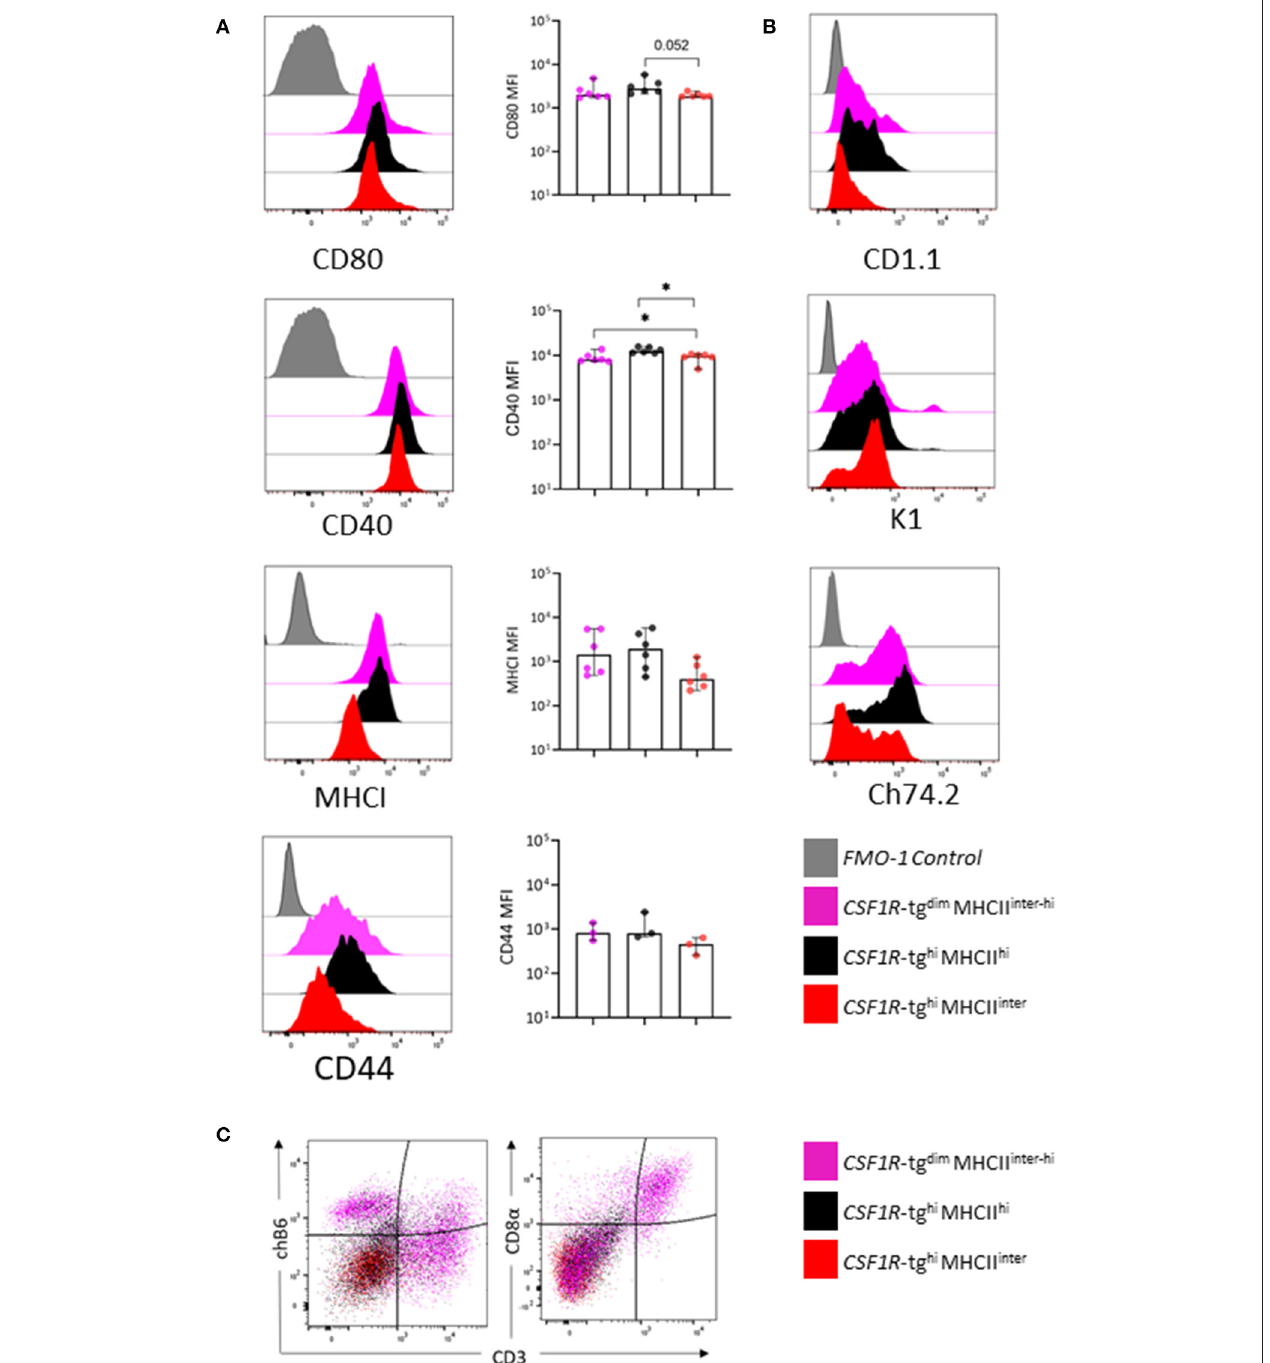
FIGURE 4 | The CSF1R -tg hi MHCII inter subpopulation express low levels of CD80, CD40, MHCI, CD44, and Ch74.2. The three CSF1R -tg + subpopulations were gated as outlined in Figure 3A and analyzed for a number of chicken mononuclear phagocytic cell markers by flow cytometry. (A) Representative histograms and MFI expression levels of CD80, CD40, MHCI, and CD44, across the three CSF1R -tg + subpopulations; (B) representative histograms of CD1.1, K1, and Ch74.2 expression across the three CSF1R -tg + subpopulations; (C) representative flow plots of chB6, CD3, and CD8 α expression across the CSF1R -tg + subpopulations indicates that the CSF1R -tg dim MHCII inter − hi subpopulation express B cell and T cell markers along with macrophage markers. Gates were applied to size/granularity, live, single cells, CSF1R -tg + MHCII + gates using FMO controls. Data is representative of 3–6 independent experiments from 4 to 6 week old chickens. Error bars indicate 95% confidence intervals. Asterisks indicate statistical significance ( P <